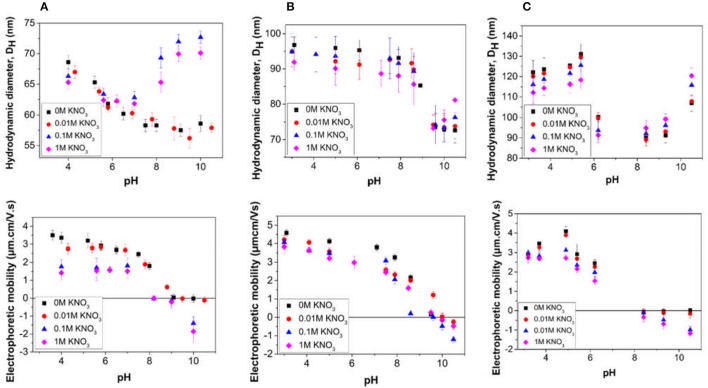
Influence of pH and electrolyte concentration on the properties of particle dispersions obtained from emulsion polymerizations conducted in the presence of the different diblock copolymers (A) LP-DMAEMA54, (B) LP-DMAEMA108 and (C) LP-DMAEMA245. Electrolyte concentrations used for the measurements were () 0 M (i.e., no added) KNO3, () 0.01 M KNO3, () 0.11 M KNO3, and () 1 M KNO3.